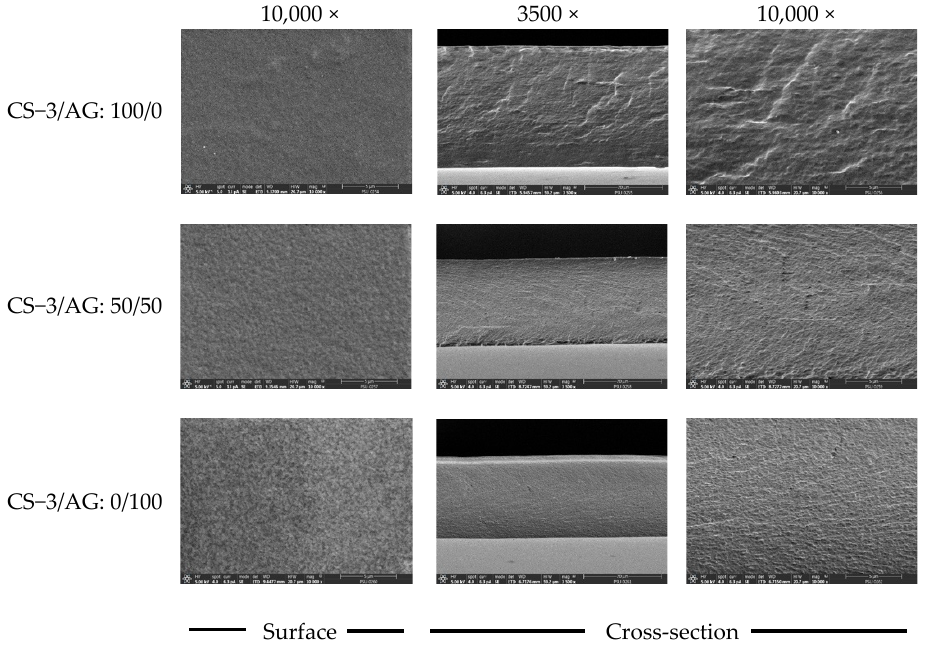
Figure 3. SEM micrograph surfaces and cross-sections of CS − 3/AG composite films with various ratios. Magnification: 10,000 × for surface; 3500× and 10,000 × for cross section.